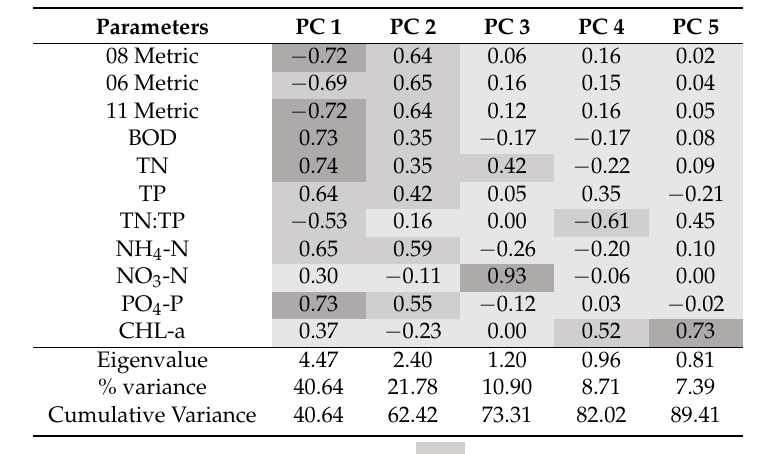
Dark shade indicates strong loading strength (>0.70); light shade indicates moderate loading strength; Very light shade indicates week or very week loading strength